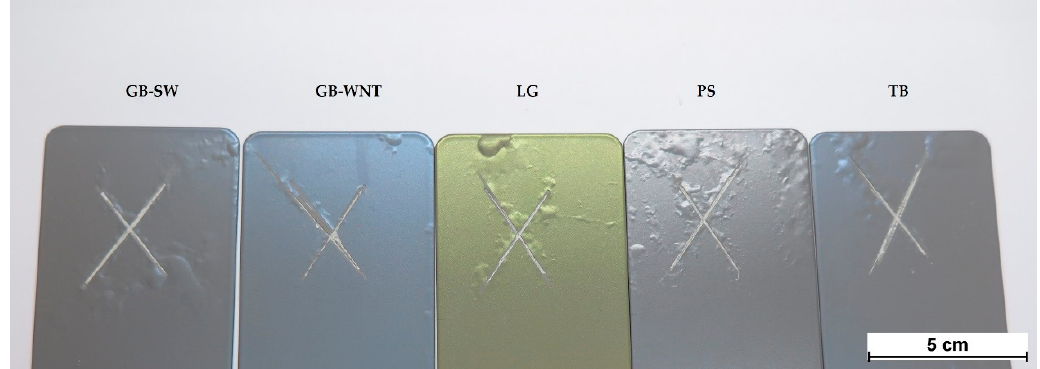
Figure 9. Samples after 1000 h exposure in an acetic salt spray chamber in the presence of an artificial scratch.